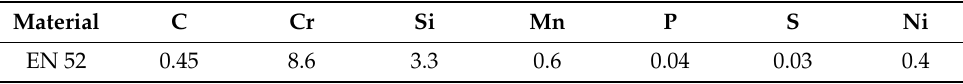
Table 1. Elemental composition of EN 52 steel.